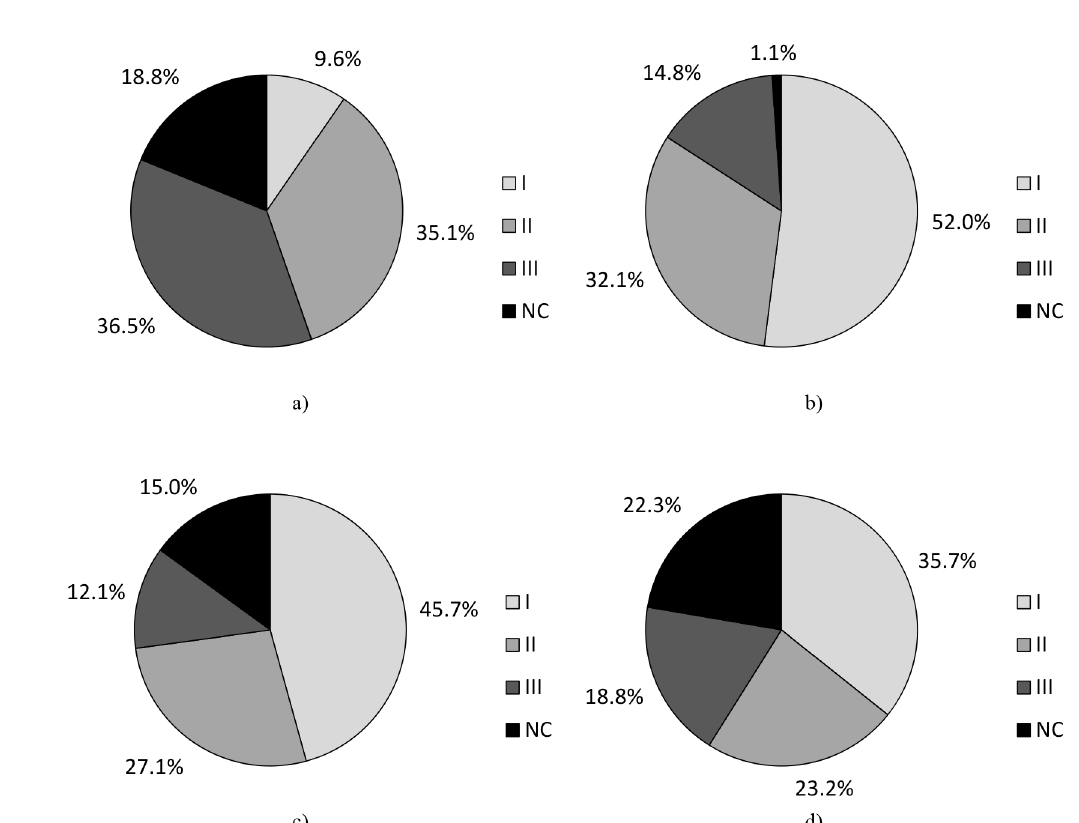
Fig. 9. Percentage distribution of segments included in each visual grading class according to UNI 11119:2004 for the entire sample: a) old beams considering damage due to external causes; b) old beams without considering damage due to external causes; c) sawn beams; d) sawn